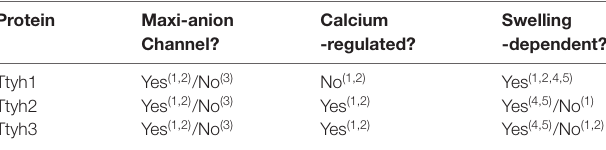
TABLE 1 | Summary table describing what is and is not agreed upon about the roles of the Tweety homologs as maxi-anion channels and the mechanisms by which they are